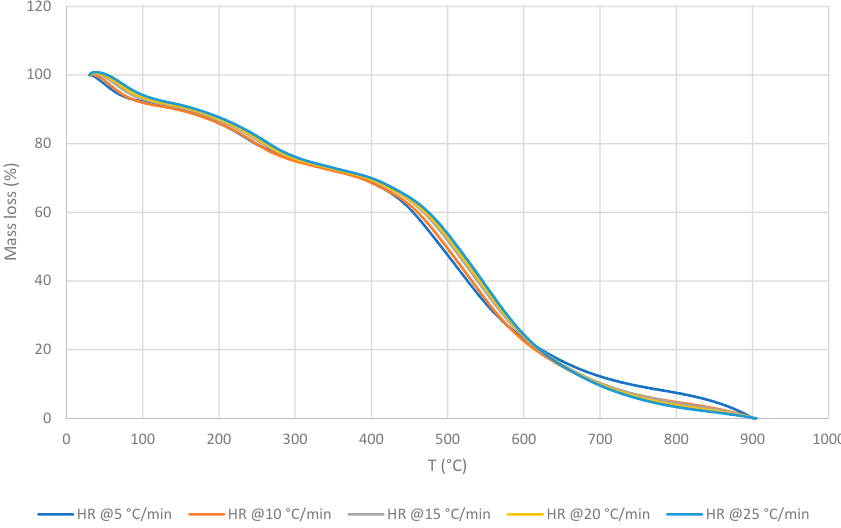
Figure 4. TGA traces of the outer squared mesh (OSM) layer at different HRs.